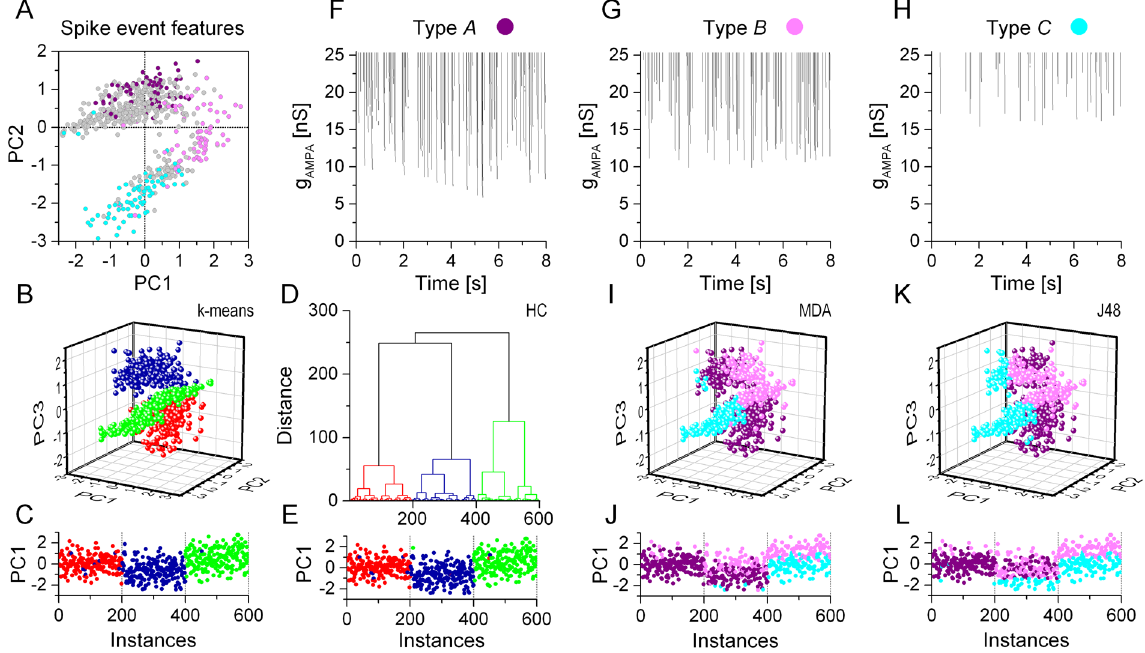
Figure 6. Unsupervised clustering algorithms perform excellently in identifying the 3 biophysical phenotypes using spike event reliability data. ( A ) Scatter plot of the first 2 PCs exhibit diffuse clusters of datapoints without indicating three distinct classes. The k-means ( B ), and hierarchical clustering ( D ) methods, however, correctly identify 3 separate groups of models corresponding to the original biophysical phenotypes (red, blue and green symbols). Sequential plots of the first PC as functions of the instance number are shown in ( C,E ). Visual inspection of the raster plots such as the ones in ( F – H ) suggests three qualitatively different firing patterns in the population of the 600 models. Correspondingly, we label model instances as belonging to one of the subjective type A , B and C classes. This set of labeled neurons (colored points in A ) serves as the training set for the 2 classification methods. Results from the MDA and the J48 algorithms are shown in ( I – L ). The classification methods reproduce the general distribution of the training dataset and the clustered data based on the ISI- parameters (Fig. 5), but the 3 classes do not match the biophysical